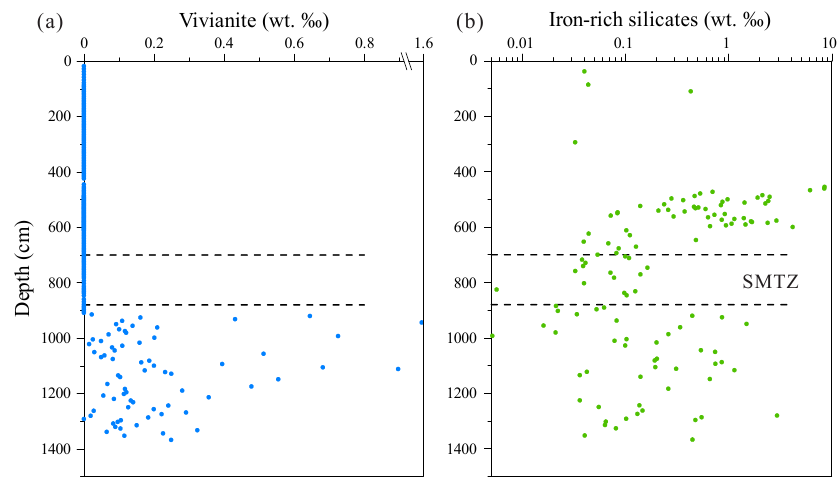
Figure 7. Depth distribution profiles of handpicked (a) vivianite and (b) Fe-rich silicates. The SMTZ is indicated by horizontal dashed